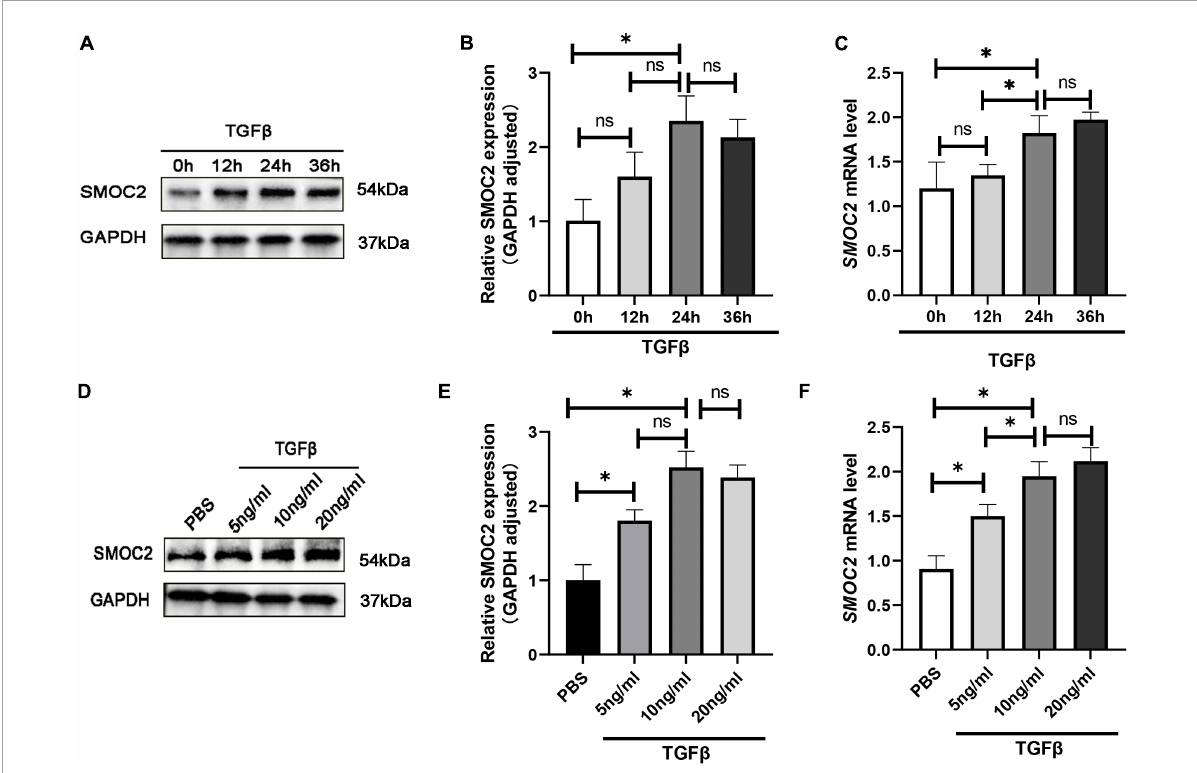
FIGURE5 SMOC2 is up-regulated in TGF β -induced cardiac fibroblasts. (A,B) Representative Western blots and quantitative results of SMOC2 in cardiac fibroblasts induced by different concentrations of TGF β ( n = 6). (C) mRNA levels of SMOC2 in cardiac fibroblasts induced by different concentrations of TGF β ( n = 3). (D,E) Representative Western blots and quantitative results of SMOC2 after induction of TGF β at different times ( n = 6). (F) mRNA levels of SMOC2 in cardiac fibroblasts after induction of TGF β at different times ( n = 3). ∗ p < 0.05. n.s.,